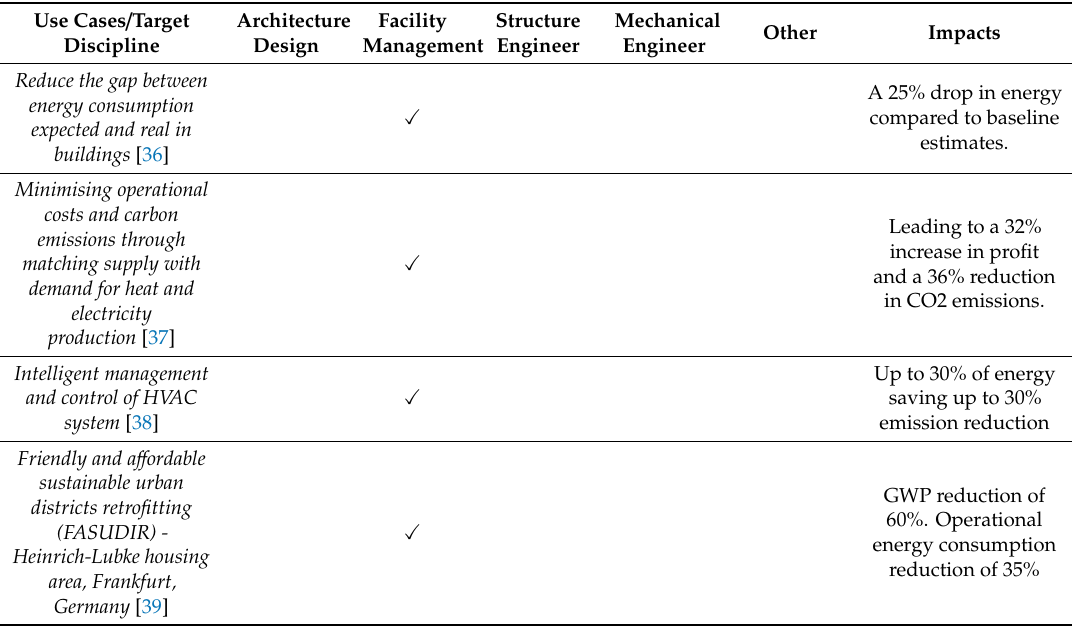
Table 2. The relevance of the discipline and its e ff